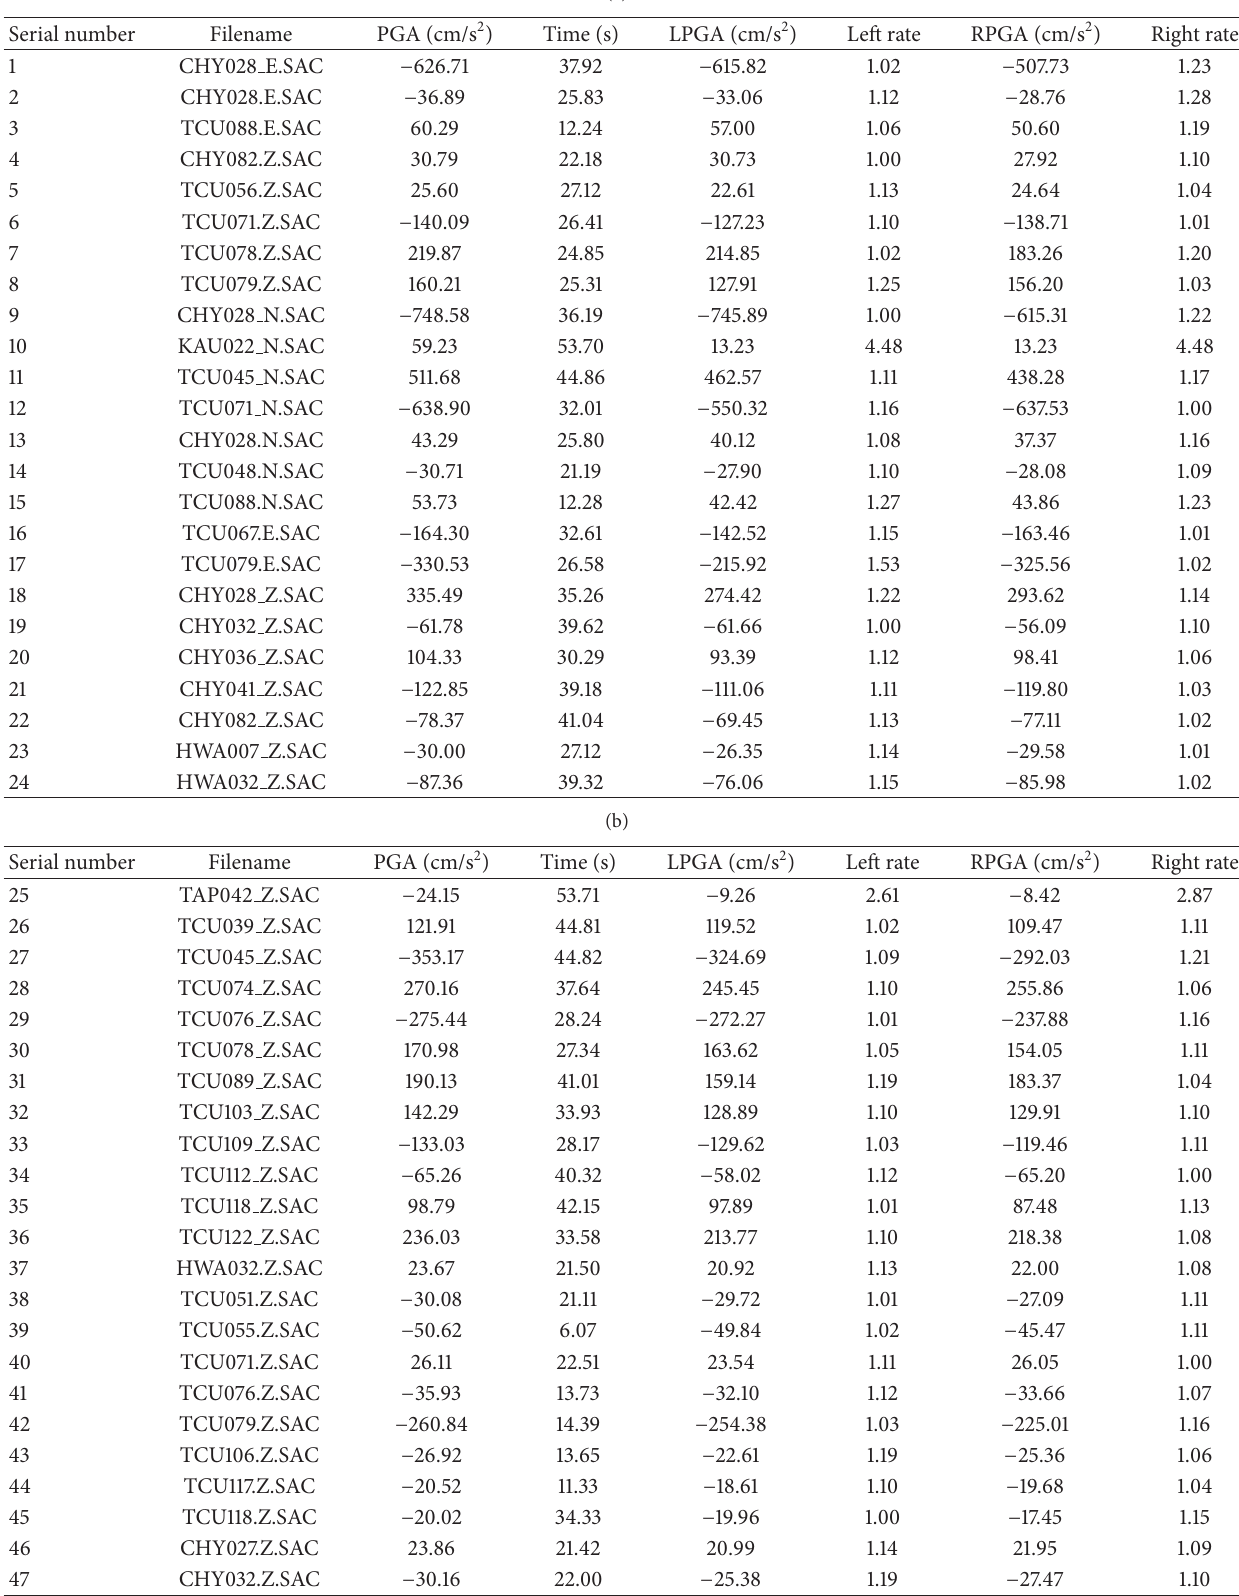
Table 1: Records with ratio of PGA to adjacent points greater than 1.1 in Chi-Chi